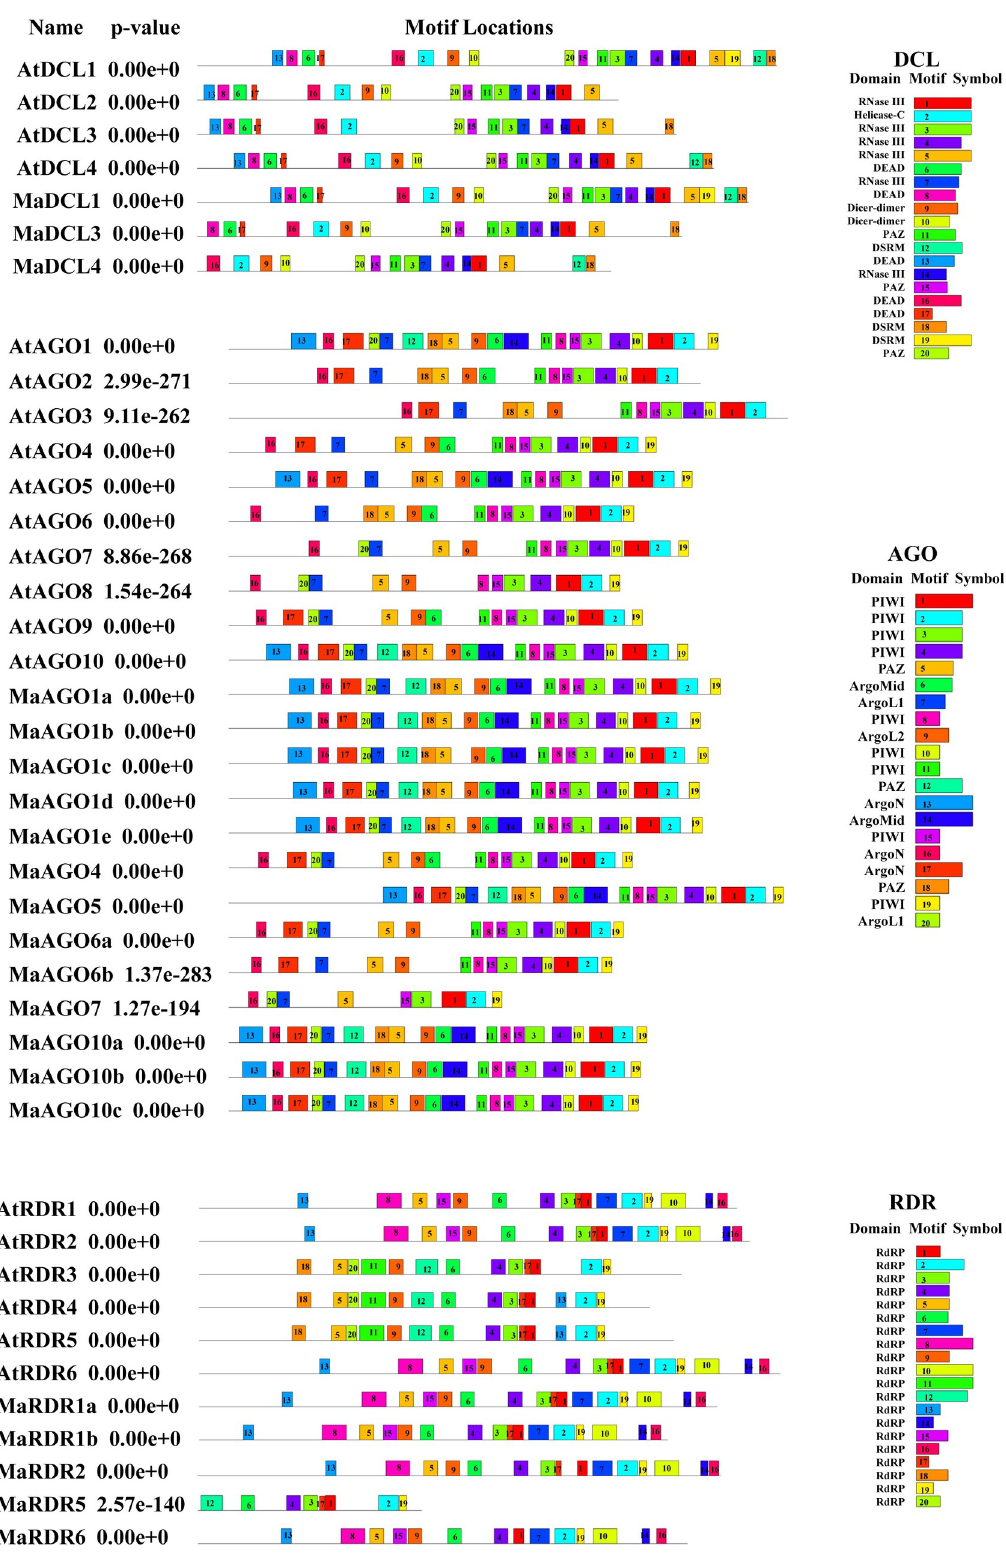
Fig 7. The conserved motifs of the predicted MaDCL, MaAGO and MaRDR protein families are drawn using MEME-suite (a maximum of 20 motifs are displayed). Each color represents different motifs in the predicted proteins domains. https://doi.org/10.1371/journal.pone.0256873.g007 PLOS ONE | https://doi.org/10.1371/journal.pone.0256873 September 2,